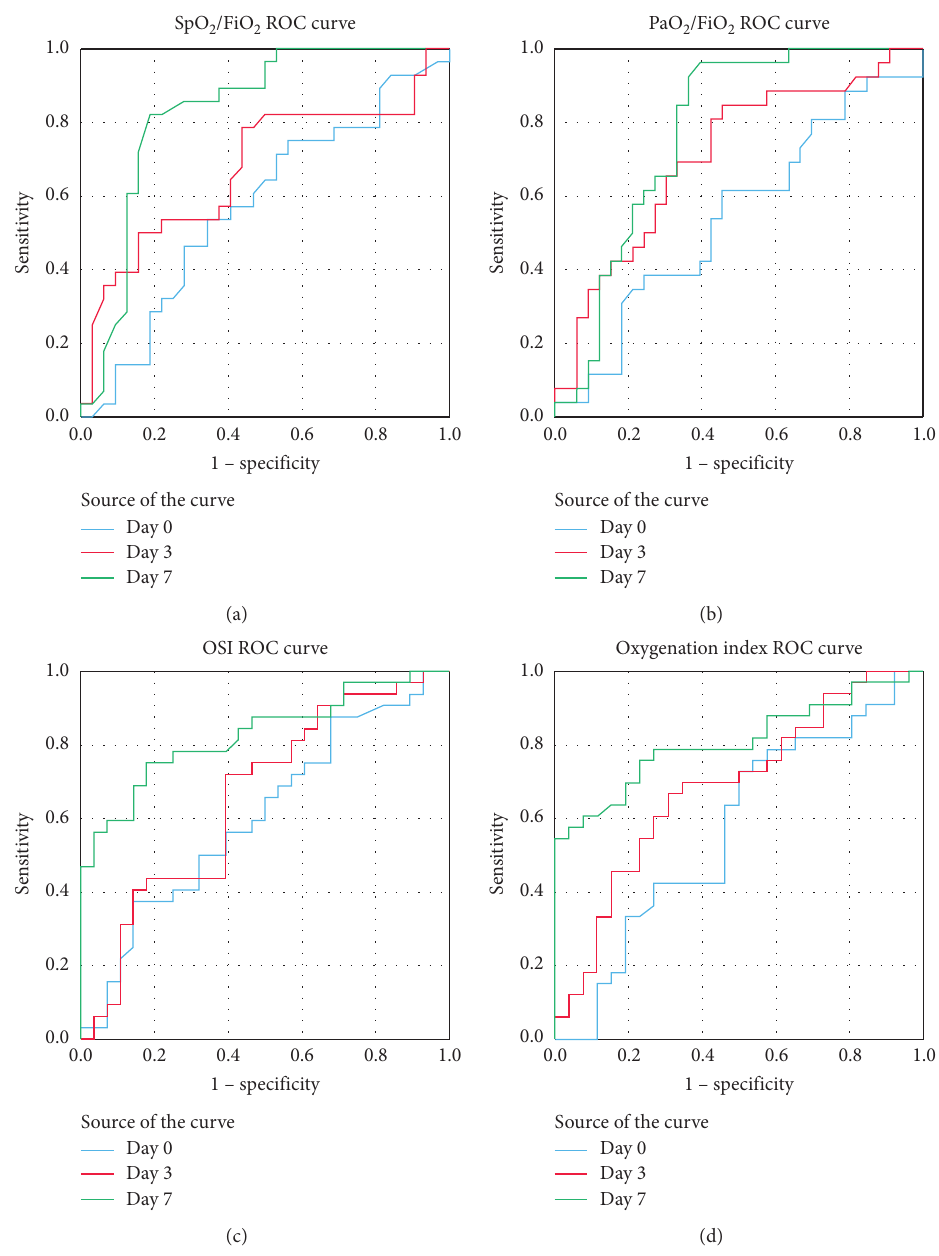
Figure 2: Reviewer operating characteristic (ROC) curves for mortality prediction. Blue: ROC curve for the intubation day 0, red for day 3, and green for day